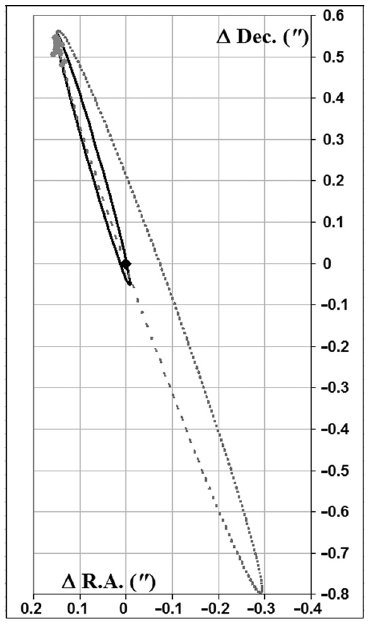
Figure 4: Orbits of